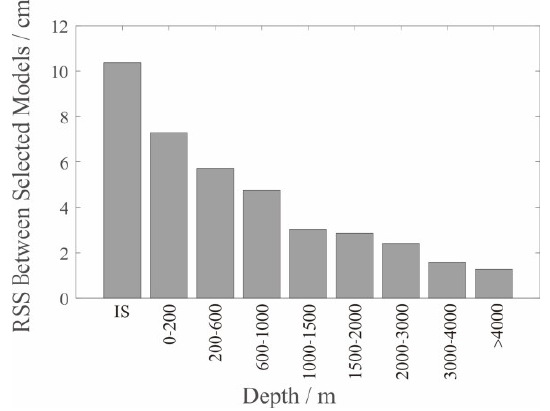
Figure 3. RSS between the six selected models, in order of increasing depth. The RSS decreases from 10.38 cm under the ice shelves, to under 4 cm in the deep oceans. (IS is short for ice shelf and those permanent sea ice regions)